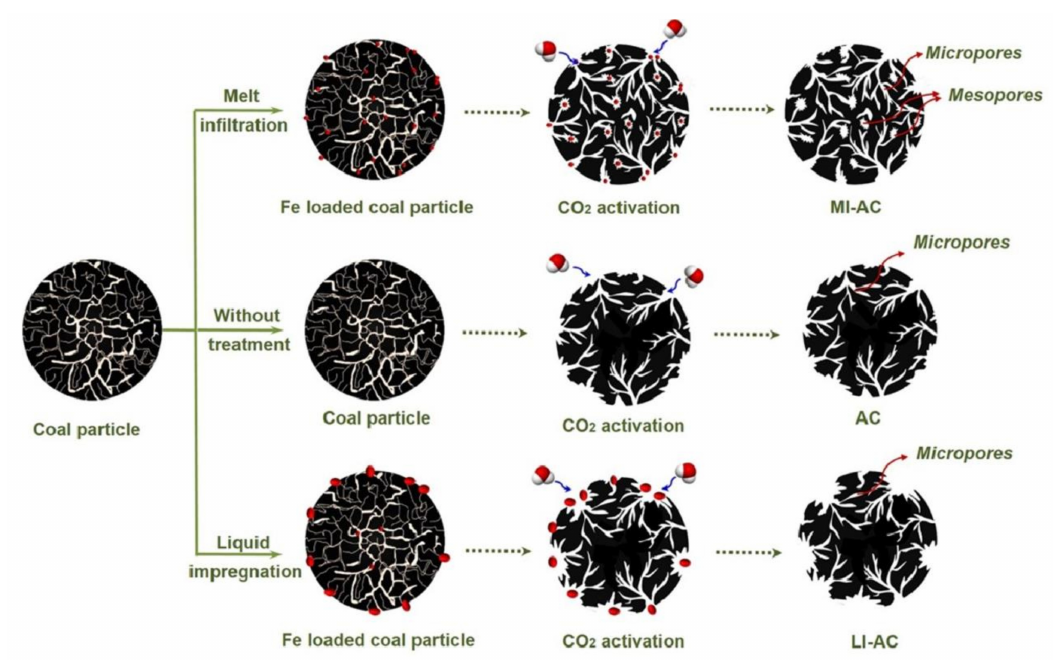
Figure 3. A schematic illustration of the porosity development mechanism by various strategies (reprinted from [81] with the permission of Elsevier,